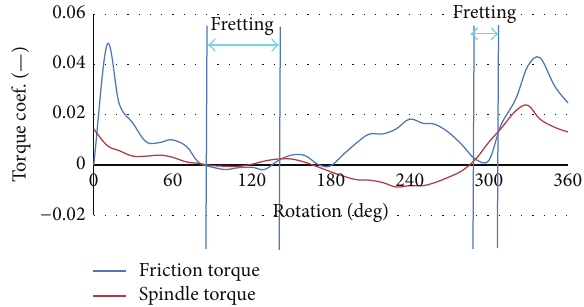
Figure 16: Fretting region of the propeller during one revolution in 𝑃/𝐷 = 1.4